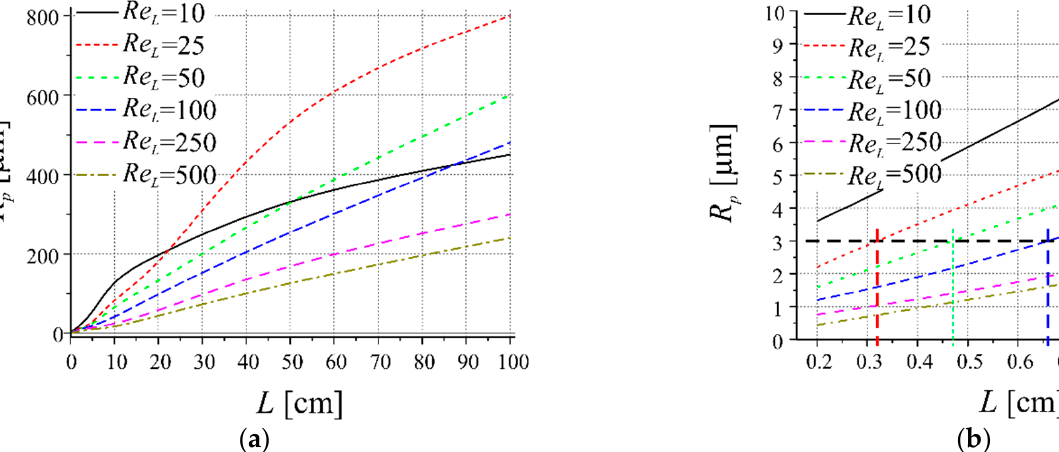
Figure 6. The size ( R p ) of the particles, which reside for maximal times inside the BLs at plates with various lengths ( L ). ( a ) for all cases, calculated within the investigated model situation and ( b ) only for the finest species (small R p